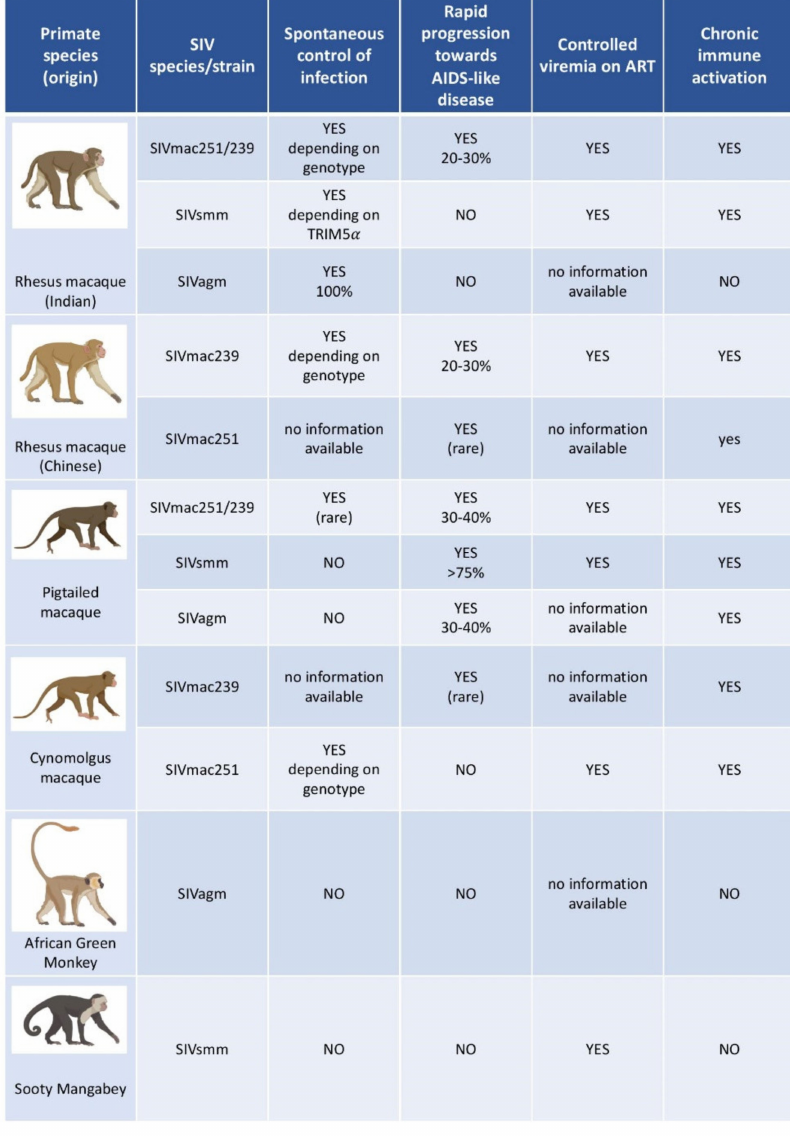
Figure 2. Main models of SIV infection in non-human primates studied in HIV research. This figure provides a non-exhaustive overview of non-human primates most often studied as models in HIV research. The principal features of each non-human species/viral strain are indicated. The viral load and other pathophysiological features vary depending on various parameters such as host species and genetic background, age, viral species or strain, laboratory, and sampling techniques, to mention just a